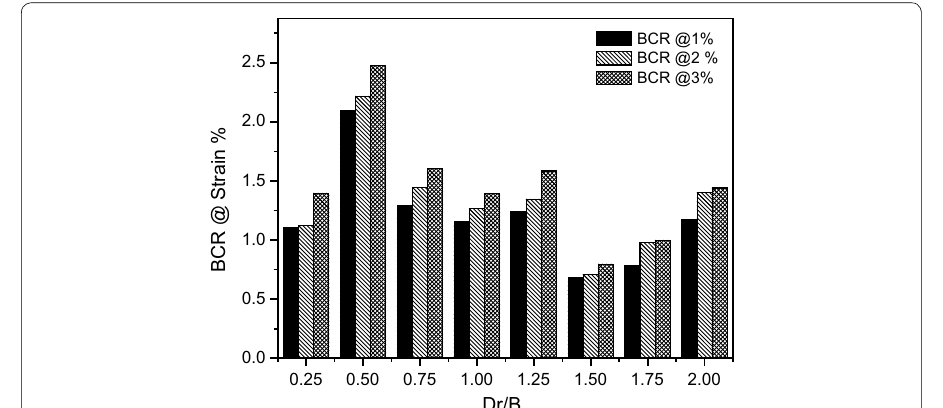
Fig. 7 BCR of reinforced soil for 1, 2 and 3% strain for 75 mm square footing